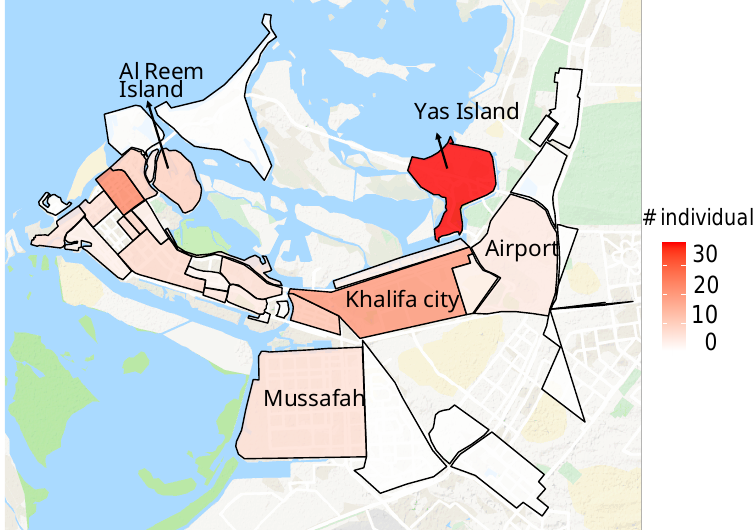
Figure 2. The distribution of users across Abu Dhabi neighborhoods (largest neighborhoods